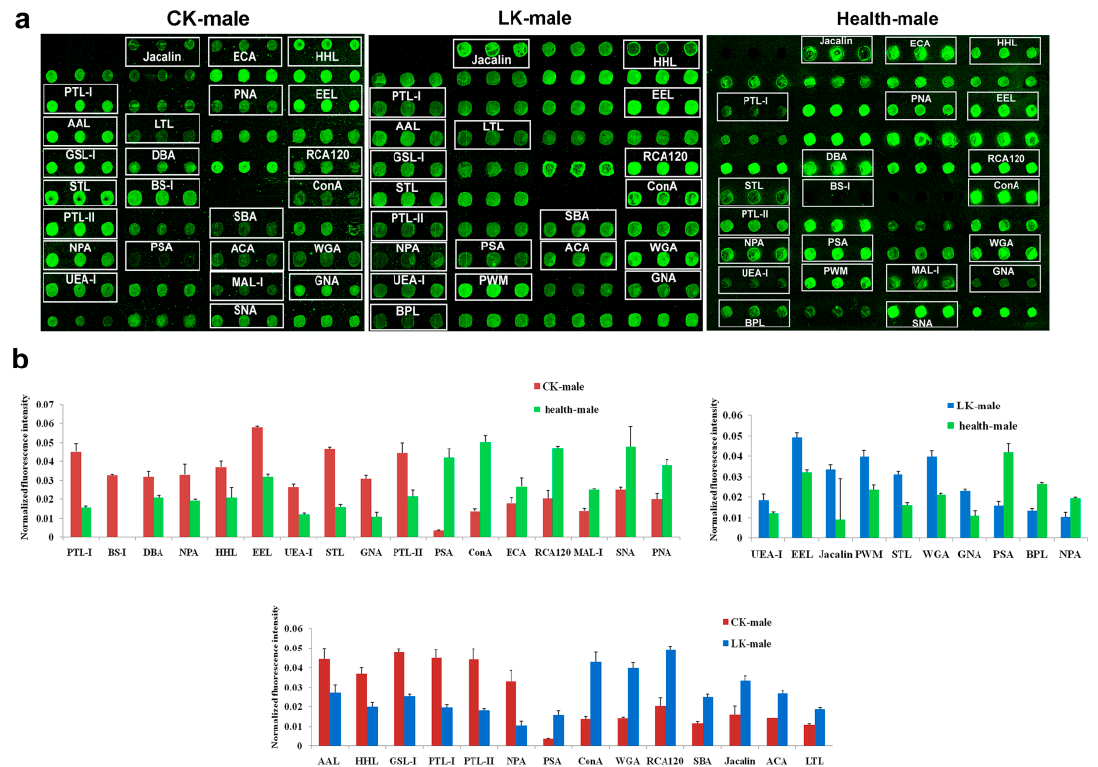
Figure 3. Male serum glycoprotein glycosylation patterns were determined by the binding of Cy3-labeled protein to 37 different lectins using a lectin microarray. CK: CKD, LK: LKD and Health: normal control. ( a ) Profiles of Cy3-labeled serous proteins from patients with CKD and LKD, and normal individuals bound to the lectin microarrays. The lectin microarrays revealed lectins that exhibited significant differences, which are marked with white frames; ( b ) Significant differences in the lectin levels among the three groups. The bars represent mean + SD of the three biological replicates from each group.